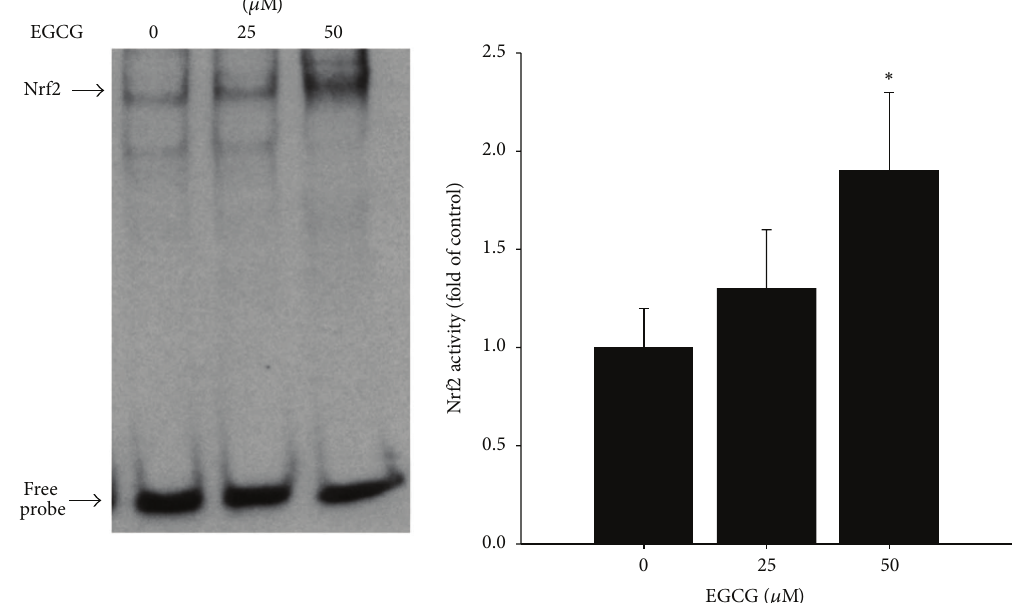
Figure 5: Effect of EGCG on Nrf-2 activation. Data are expressed as mean ± SD of three independent experiments. ∗ 𝑃 < 0.05 versus control